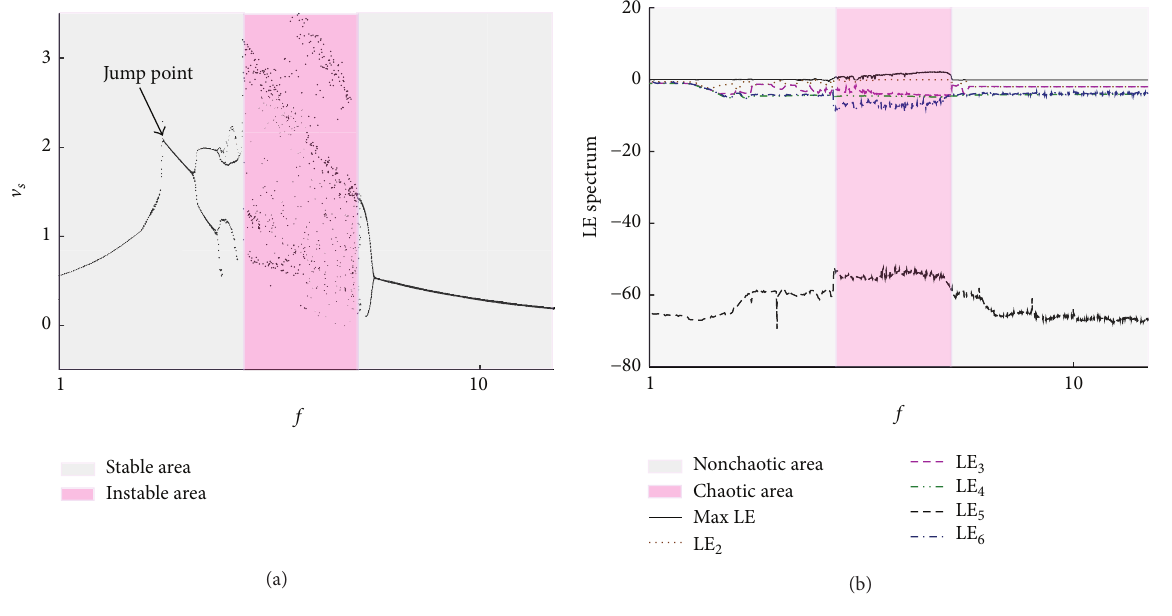
Figure 4: Frequency response diagram and LE spectrum